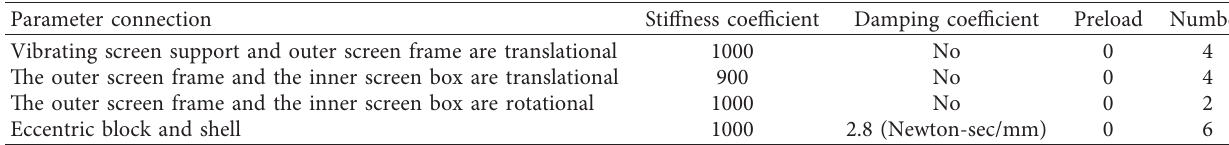
Figure 8: Setting of constraints of the virtual prototype of the chaotic vibrating screen. Table 2: Elastic load parameter setting of virtual